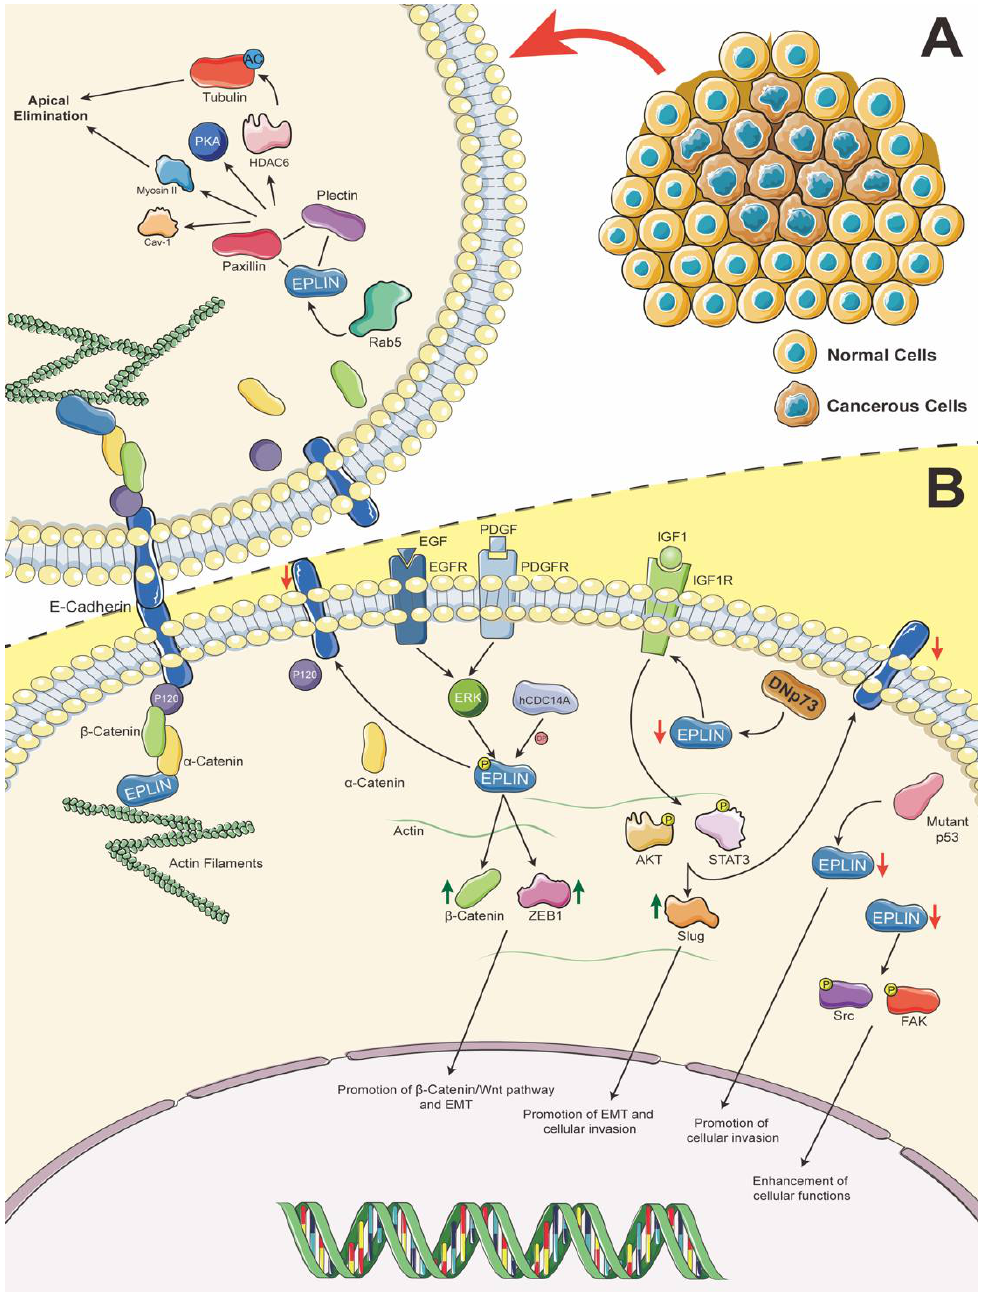
Figure 2. A. Role of EPLIN in apical extrusion. Rab5 allows disruption of the connection between the cadherin–catenin complex and EPLIN, allowing EPLIN to interact with paxillin and plectin to recruit/activate Cav-1, PKA and Myosin II, and acetylate tubulin through paxillin’s regulation of HDAC6 activity. Hence, promoting apical elimination when Ras-transformed cells are surrounded by normal cells. B. EPLIN prospective pathways in epithelium. EPLIN stabilises AJs and actin dynamics by binding to the cadherin–catenin complex and actin directly. PDGF/EGF could induce phosphorylation of EPLIN via ERK signalling pathways and results in disorganisation of AJs and interruption of actin dynamics, which further upregulates expression/translocation of β -catenin and ZEB1, diminishes expression of E-cadherin leading to activation